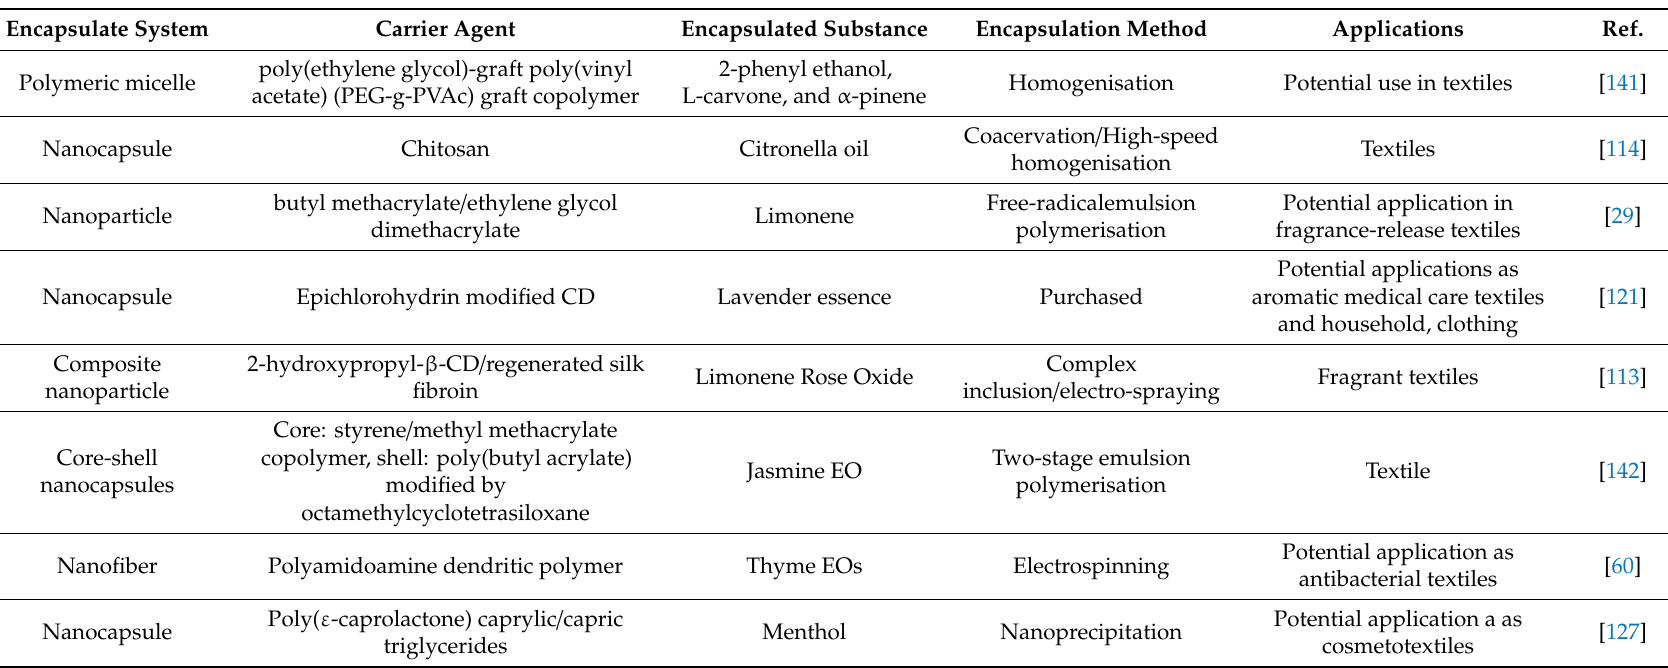
Table 2. Recent studies reporting nanoencapsulation of fragrances and flavours for textile